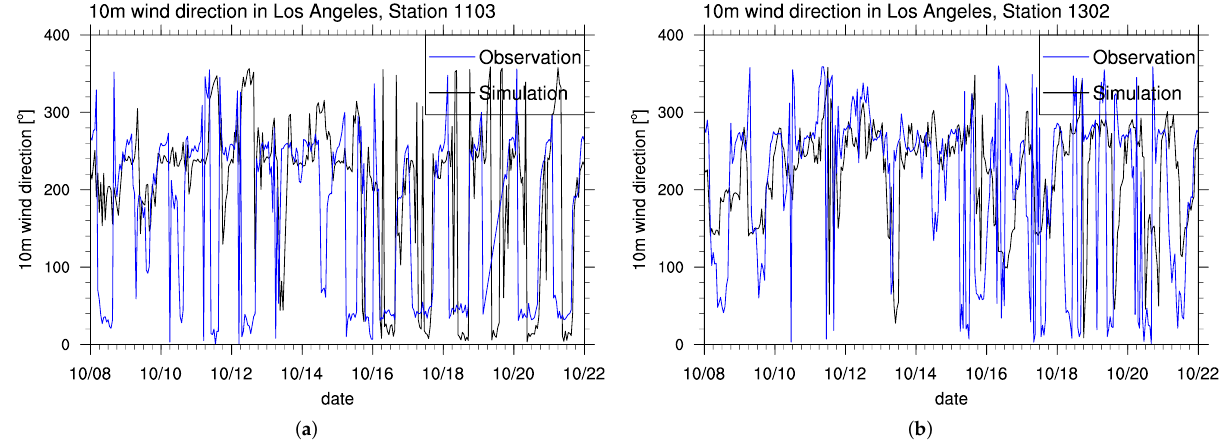
Figure 4. Comparison of in situ measurements with modeled wind direction at LA North Main Street ( a ) and Compton ( b ) in October